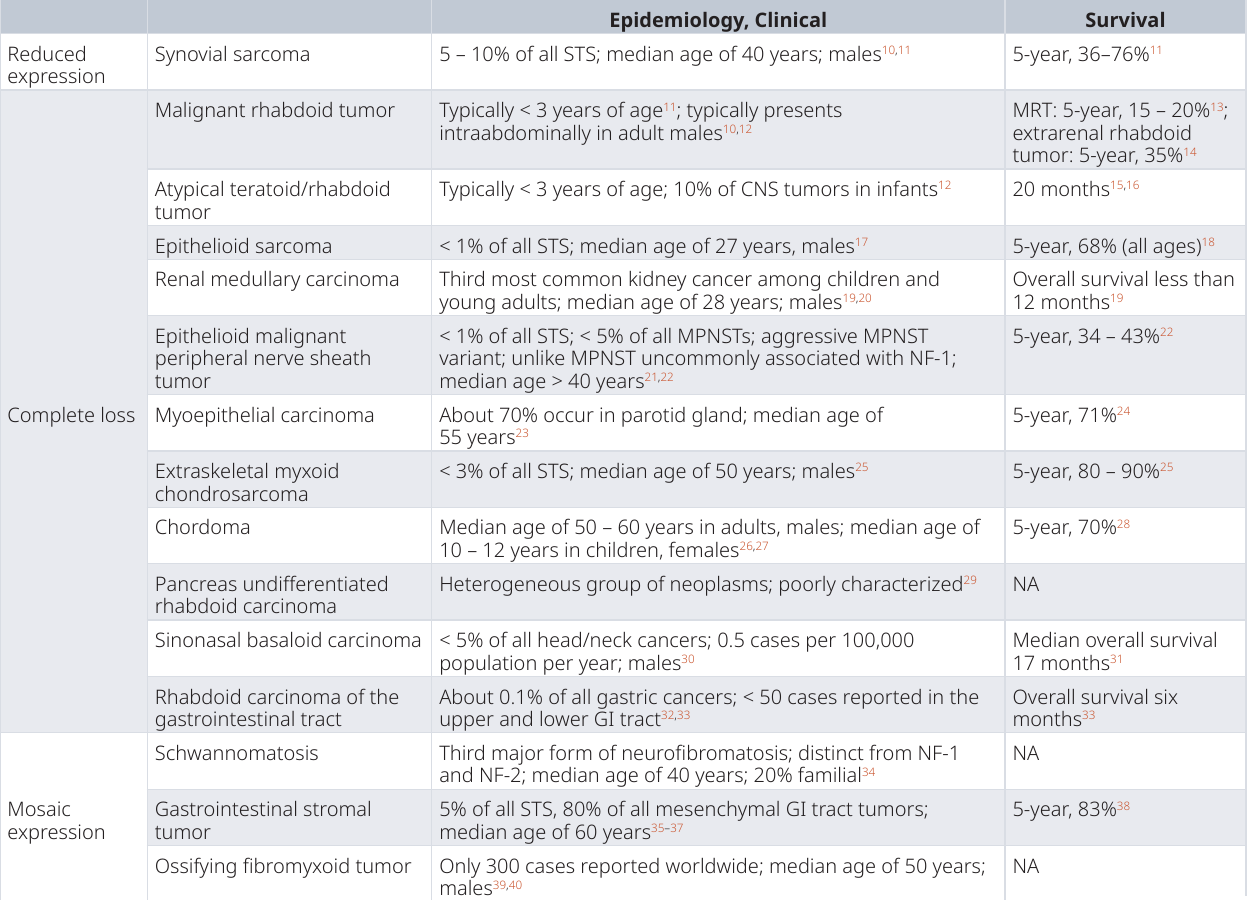
Table 1. Epidemiologic, selected clinical, and prognostic data for SMARCB1/INI1-deficient tumors. STS, soft tissue sarcomas; MRT, malignant rhabdoid tumor; CNS, central nervous system; MPNST, malignant peripheral nerve sheath tumor; NF-1, neurofibromatosis type 1; NF-2; neurofibromatosis type 2, GI, gastrointestinal; NA, data not